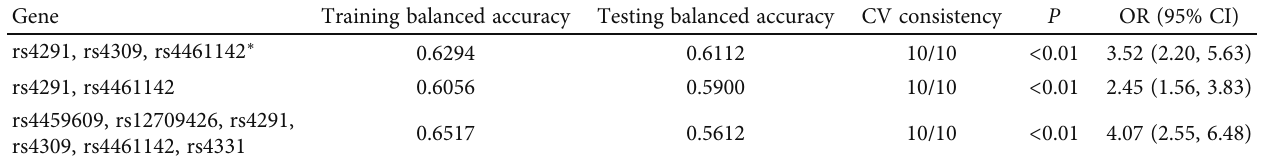
Table 5: The interaction of ACE gene polymorphism in the EH